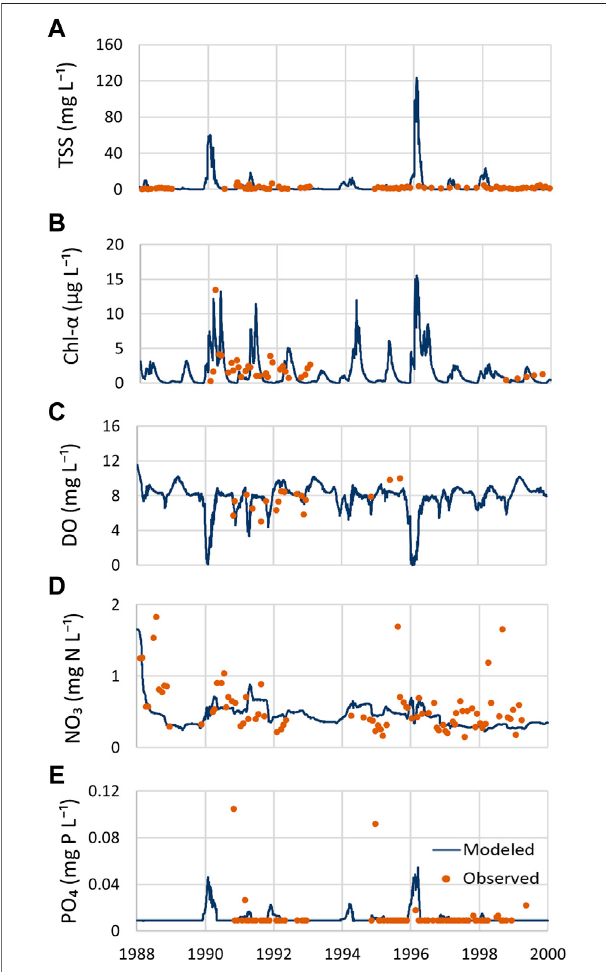
FIGURE 6 | Modeled and observed data comparison for (A) sediment, (B) oxygen, (C) phosphate, (D) nitrate, and (E) chlorophyll-a.